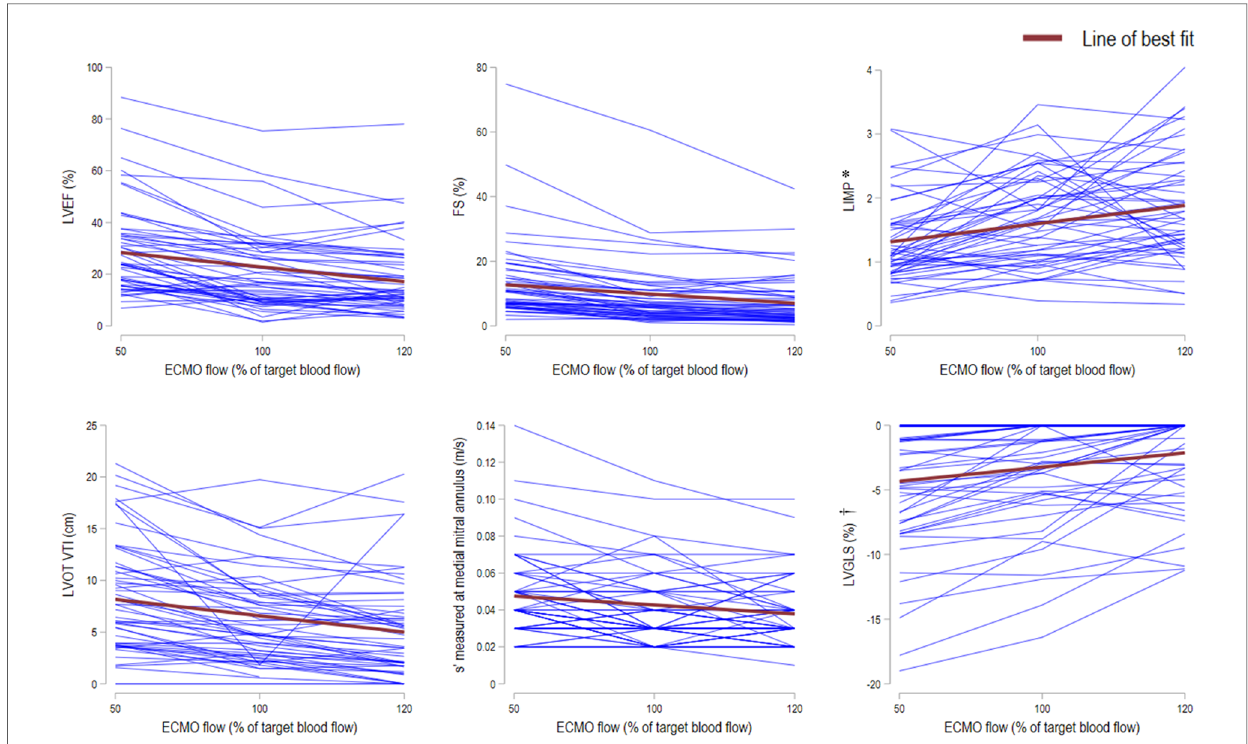
FIGURE 2 Spaghetti plots for various measures of left ventricular function against ECMO target blood fl ow. The plots of LVEF (left ventricular ejection fraction; top left), FS (fractional shortening; top middle), LIMP (left ventricular index of myocardial performance; top right), LVOT VTI (left ventricular out fl ow tract velocity time integral; bottom left), s ’ (peak systolic tissue velocities measured at medial mitral annulus; bottom middle), and LV GLS (left ventricular global longitudinal strain; bottom right) against ECMO target blood fl ow of 50%, 100%, and 120% ( n =54). Each blue line represents an individual participant. The line of best fi t for each plot is shown in red. * LIMP: higher values indicate more impaired systolic function. † GLS (%): the “ negative ” sign indicates myocardial shortening. Higher negative % values indicate more pronounced longitudinal shortening, whereas values closer to zero indicate less shortening (i.e., more impaired systolic